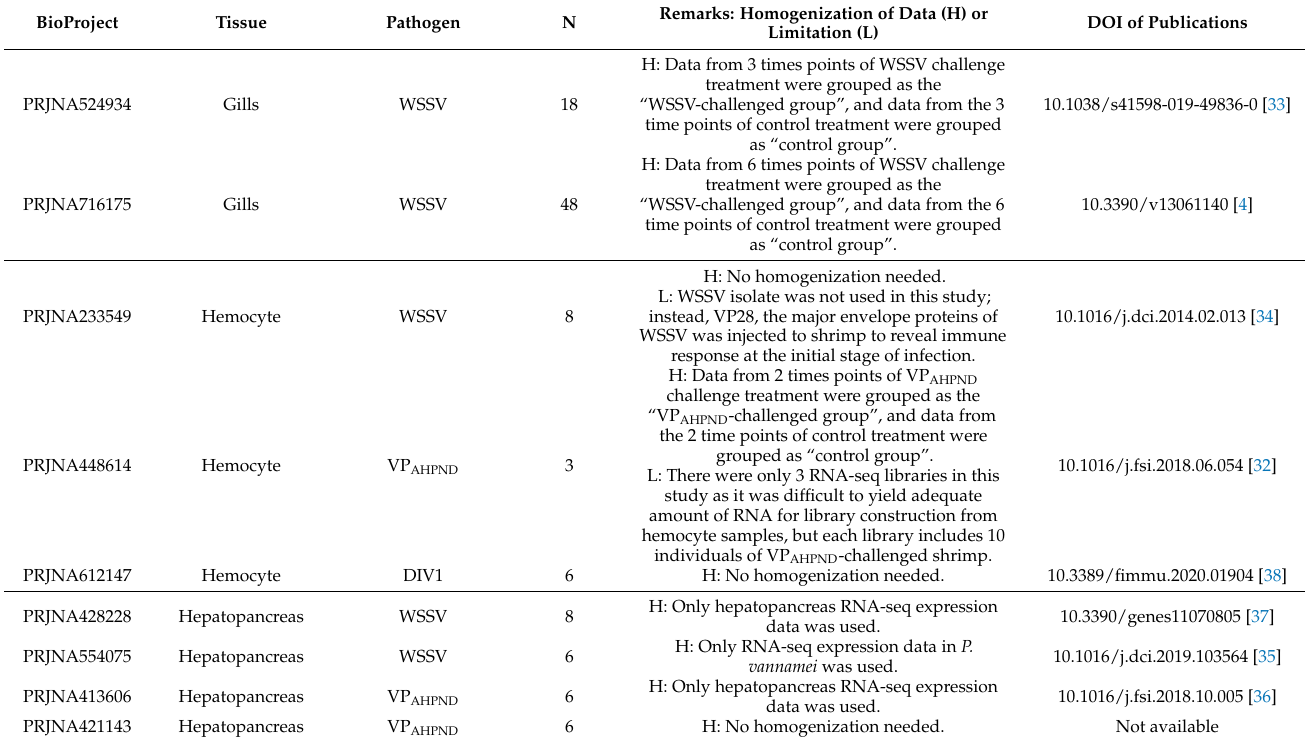
Table 2. Transcriptome data analyzed in this study. N: Number of transcriptome expression